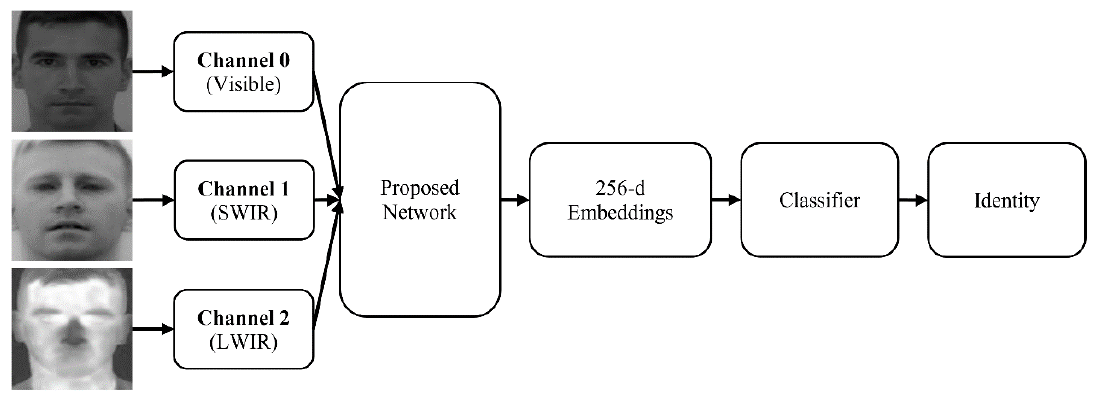
Figure 3. Architecture of the implemented facial recognition